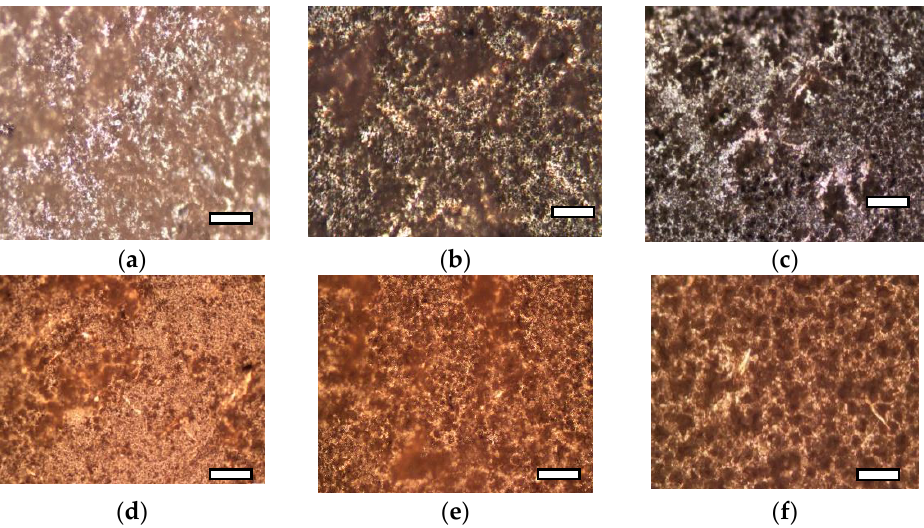
Figure 3. SEM images of the surface ( a – c ) and cleavage ( d – f ) of the PHBV/PCL/CNC composite films: PHBV/PCL(1:1)/CNC(PAM)–5 ( a , d ); PHBV/PCL(1:1)/CNC(PAM) − 10 ( b , e ); PHBV/PCL(1:1)/CNC(PAM)–15 ( c , f ). The scale is 2 µ m ( a , b , d , e ); 1 µ m ( c , f ).